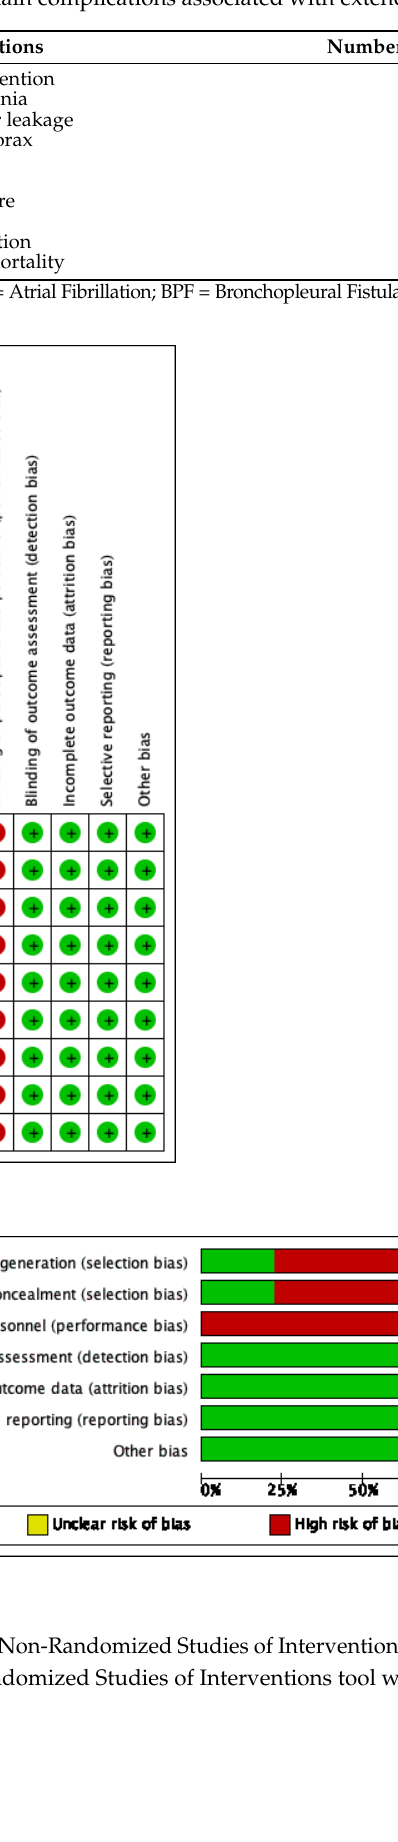
Table 2. Summary of the main complications associated with extended sleeve lobectomy (ESL).